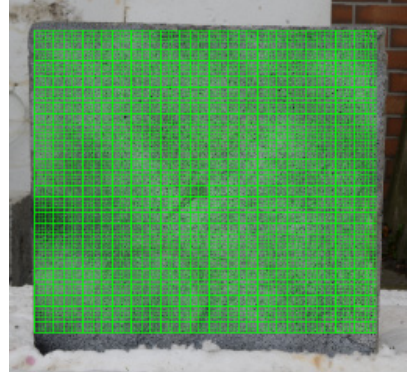
Figure 11. Grid of subsets in the unheated surface.